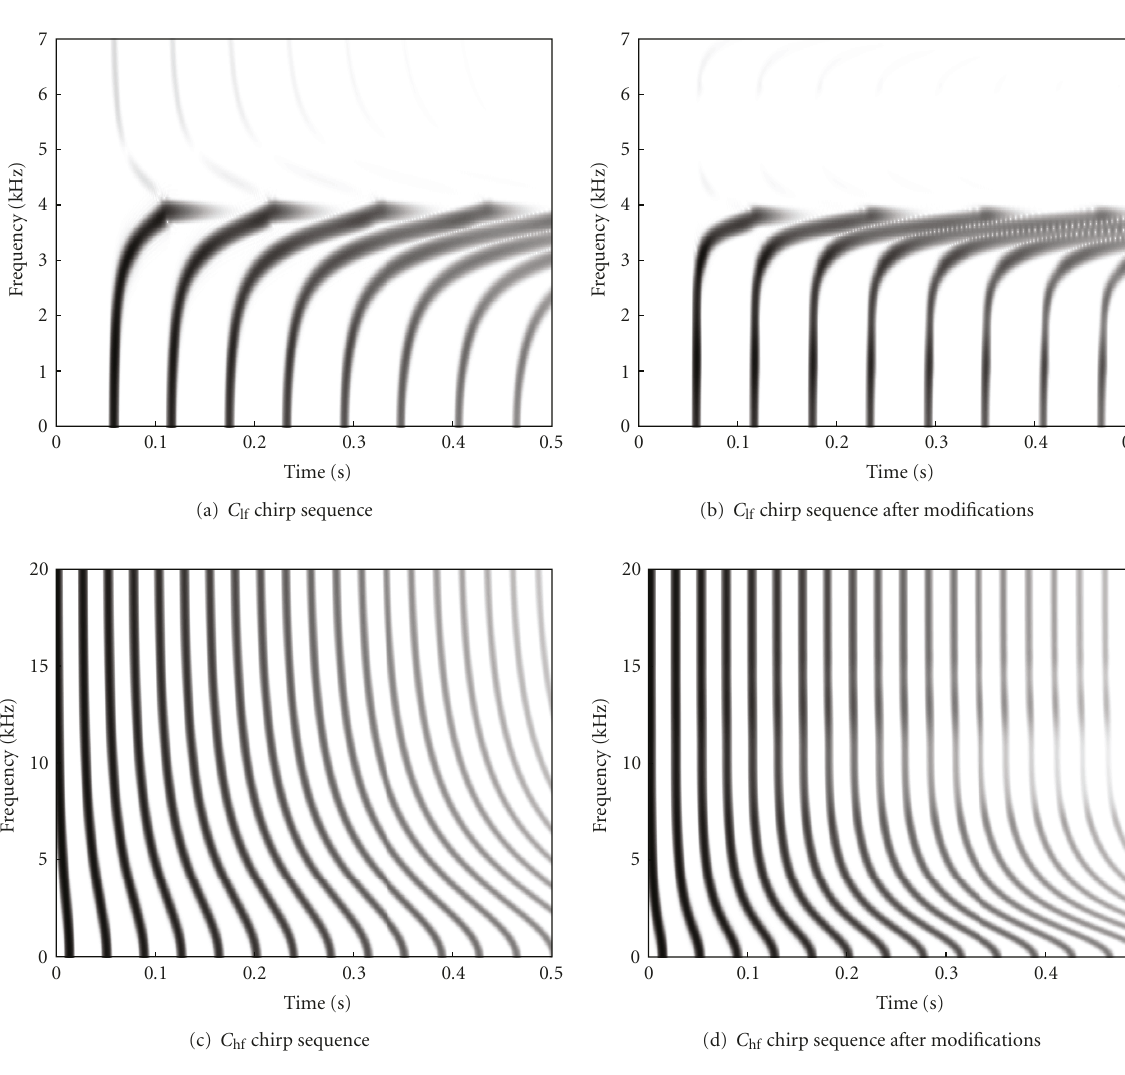
Figure 6: Spectrograms showing chirp sequences produced by the original and modified structures.